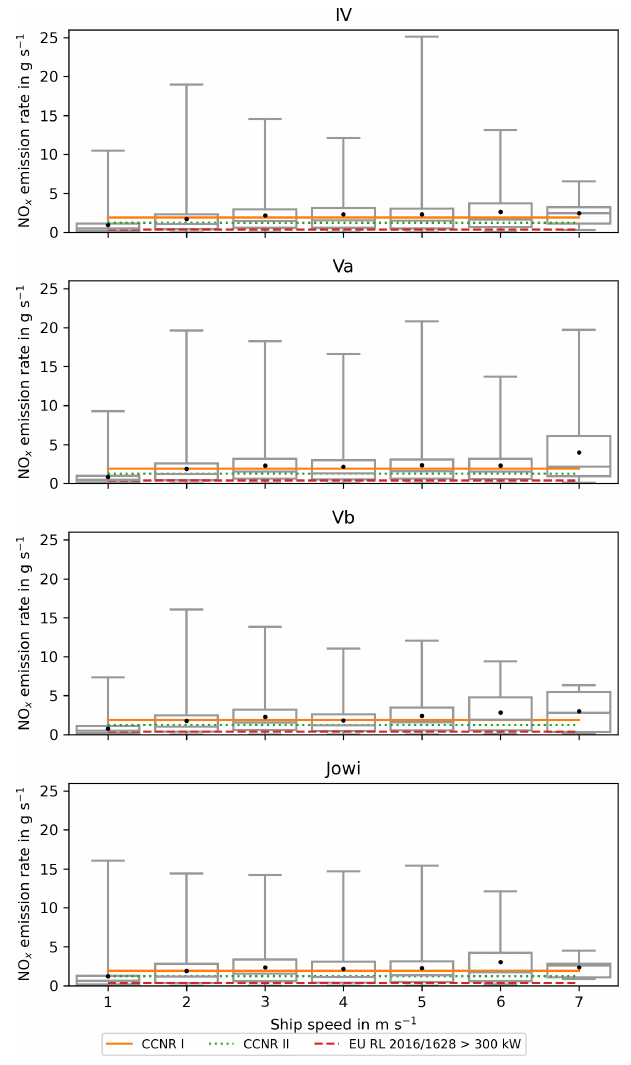
Figure 10. Box plots of NO x emission rates for ship classes IV, Va, Vb, and Jowi as a function of ship speed over ground, as de- rived from data measured at DURH. The mean value is shown as a black dot and the median value as a grey line. The limits given by the CCNR I, CCNR II, and EU RL2016/1628 regulations were con- verted (from gkWh − 1 to gs − 1 ) and are shown as lines (see Table 6 for more